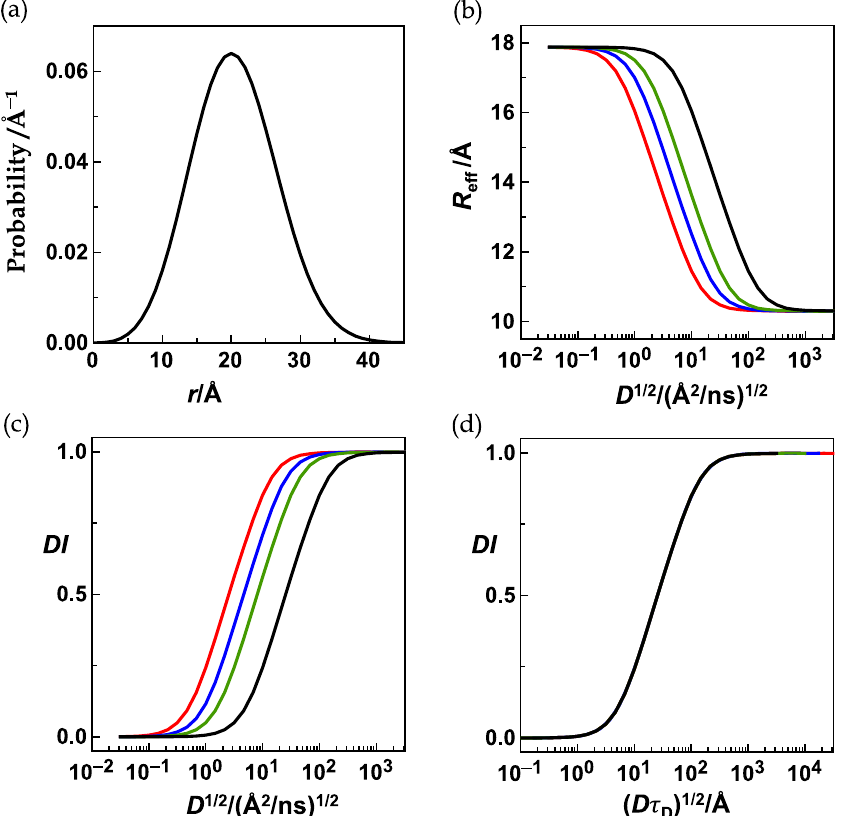
Figure 4. ( a ) A 3-D Gaussian distance distribution ( b ) Four diffusion profiles obtained with ( a ) four different donor lifetime constants, 𝜏 D , of 100 ns (red), of 30 ns (blue), of 10 ns (green), and of 1 ns (black). The Förster radius ( R 0 = 15 Å) and the left integration limit ( r L = 3 Å) were held constant. ( c ) Diffusion-influence profiles after normalization. ( d ) The DI -profiles coincide when the DI values are plotted against the square root of the product of diffusion coefficient and donor lifetime.